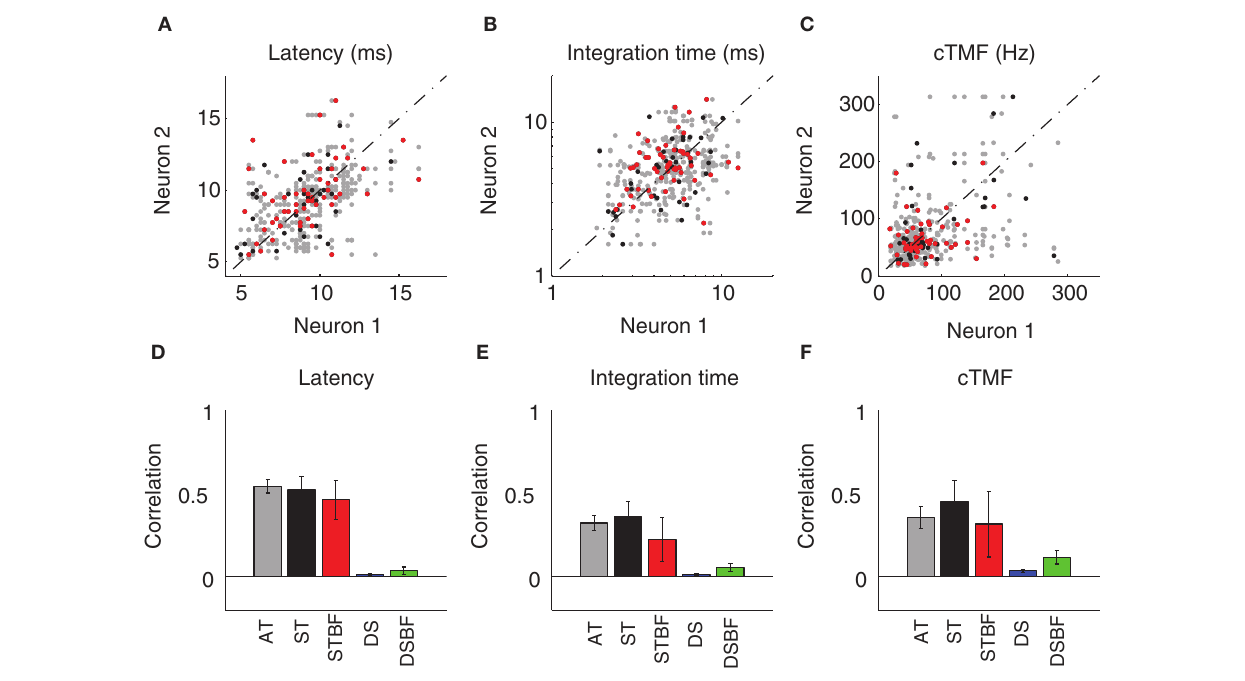
similarity for each of the temporal parameters between neighboring neurons. The correlation coefficient is shown for each of the experimental groups as well as for two reference controls (DS, blue ; DSBF, green ). Statistics for the temporal parameter comparisons are provided in Table 2 . The error bars in D–F represent the bootstrapped SE of the correlation coefficient.